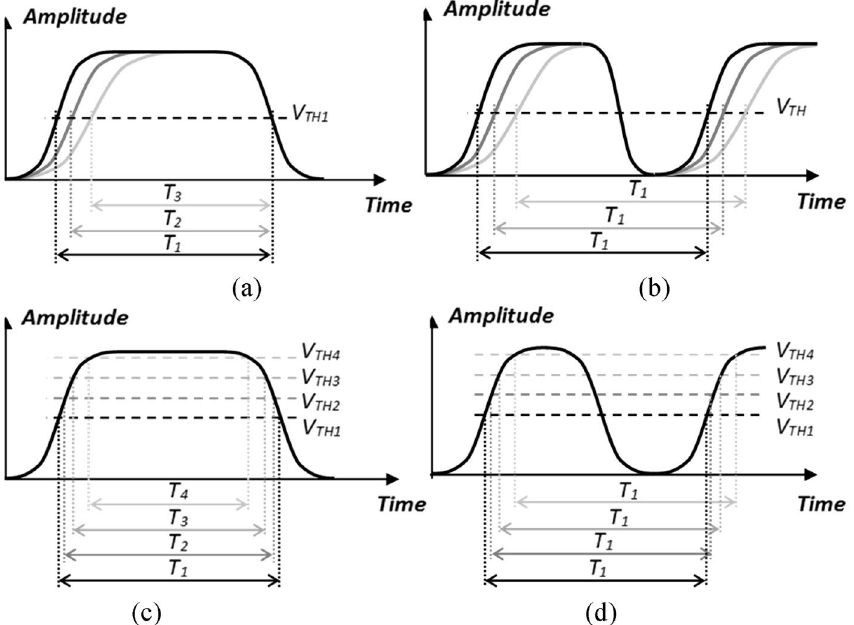
Figure 7. Illustration of the superiority of the IPM scheme to other anisotropic modulation schemes in terms of resilience against systematic imperfections in pulse widths and upon pulse-width measurement. ( a ) Non- equal rise/fall times cause pulse-width error in regular anisotropic modulation schemes (e.g., PIM and PIWM). ( b ) In the proposed scheme (IPM) pulse-width is not affected by the difference between rise and fall times. ( c ) Contribution of the detection threshold level to symbol error in regular anisotropic modulation schemes. ( d ) Robustness of the proposed scheme (IPM) against threshold level